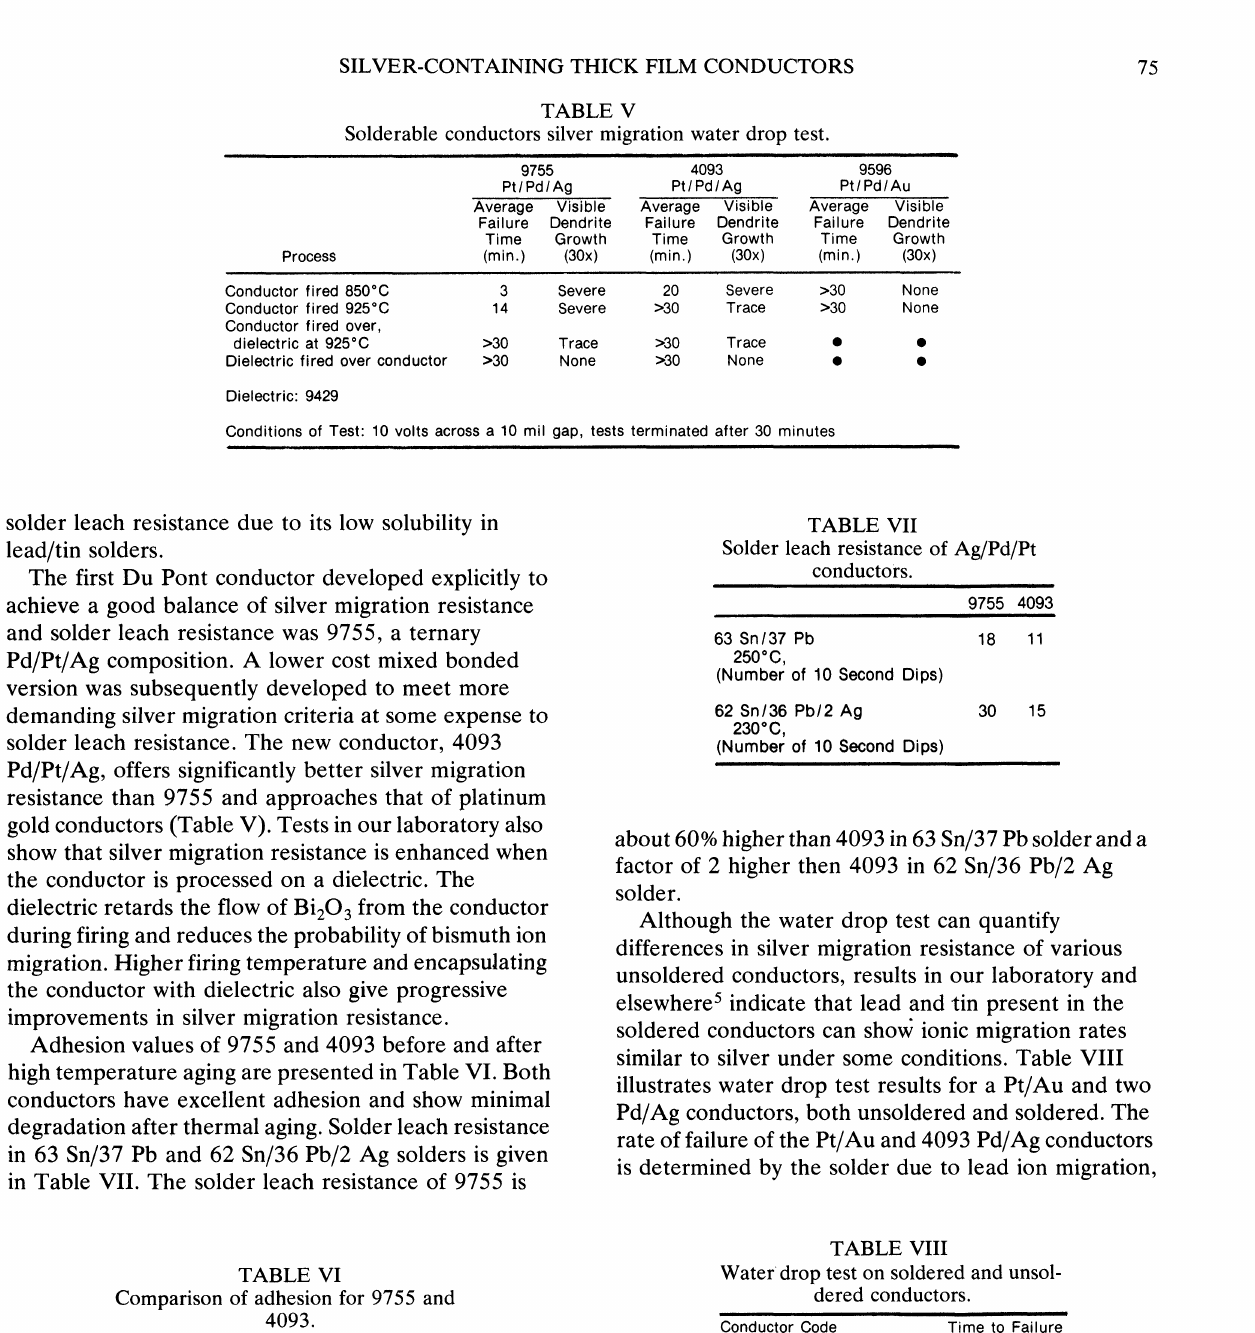
TABLE VI Comparison of adhesion for 9755 and